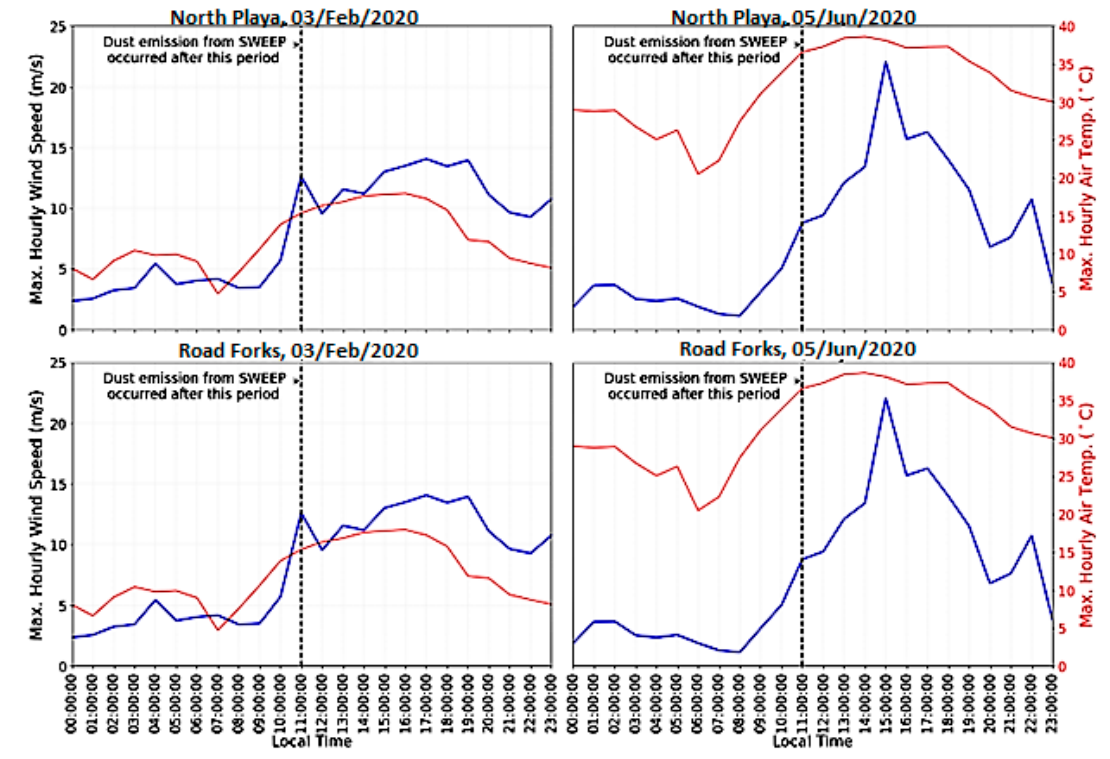
Figure 4. Meteorological data for wind speed and air temperature, required by SWEEP for the two sites and cases.